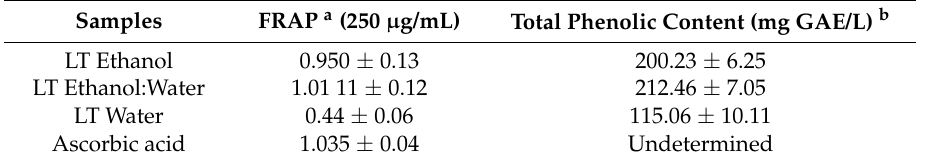
Table 2. Summary data of the assays performed in this study: FRAP and Total phenolic content assays. Samples